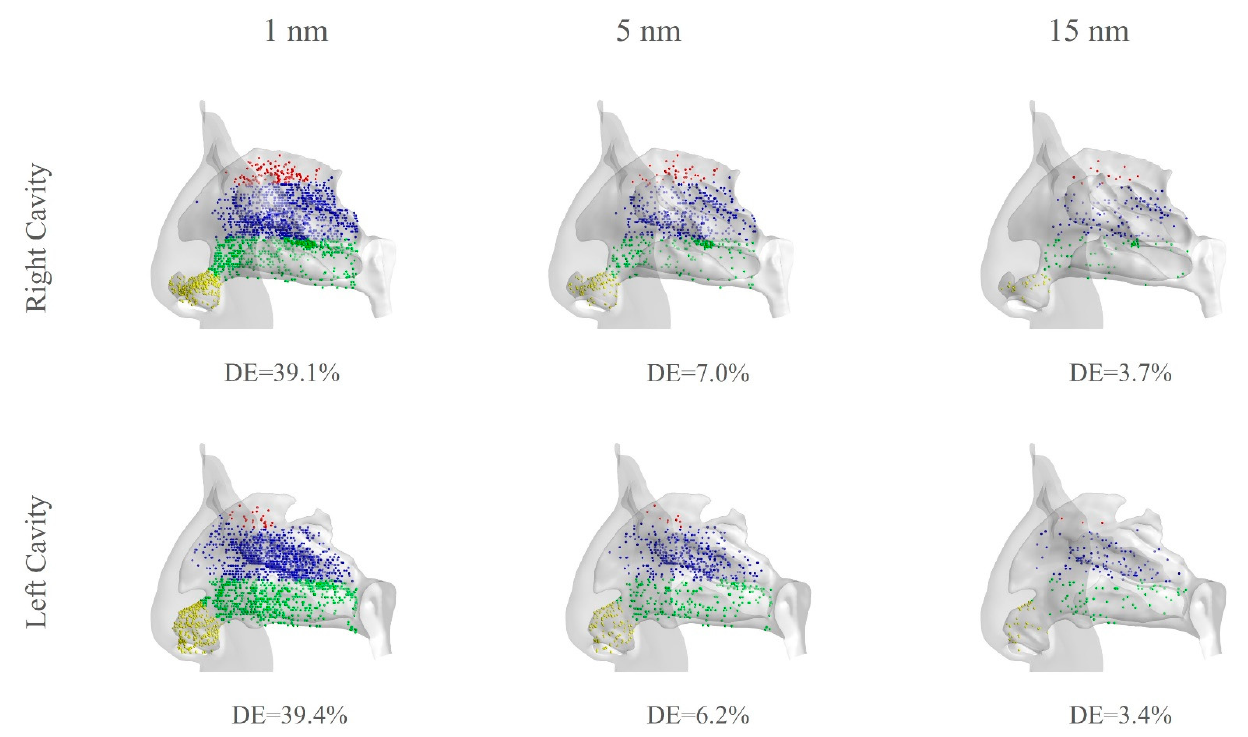
Figure 12. Spatial deposition patterns of 1, 5 and 15 nm particles: yellow dots stand for deposited particles in the vestibule region, green dots stand for deposition particle in the inferior meatus, blue dots represent the middle meatus deposition, red dots represent the olfactory deposition.